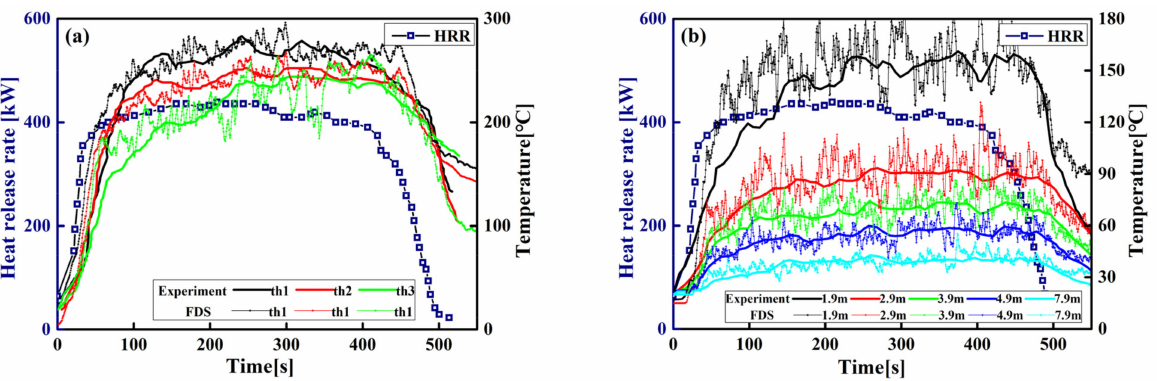
Figure 2. Comparison between the experiments and FDS simulations: ( a ) the internal temperature of the cabin; ( b ) the temperature of the plume area in PolyU/USTC atrium.